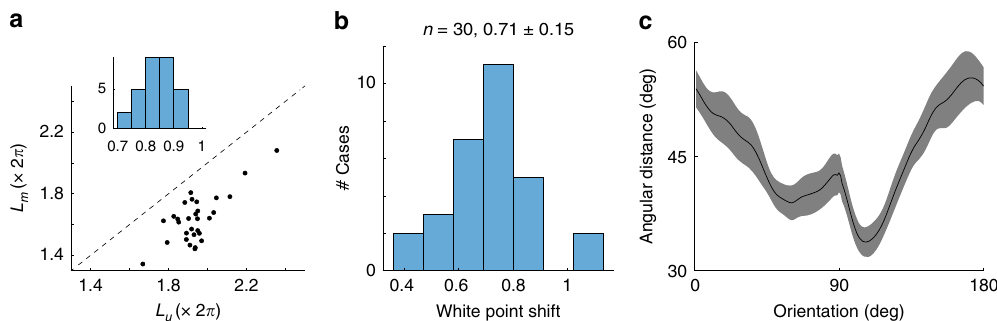
Fig. 5 Basic geometric properties of population representations in unmasked and masked conditions. a Shrinkage of the length of the curves by the introduction of the mask. Scatterplot shows the lengths of the curves in unmasked ( L u ) and masked ( L m ) conditions. Dashed line represents the unity line. Inset shows the distribution of L m / L u across all experiments. b Distribution of white-point shift ( Δ ) across all experiments. c Measurements of the angle between r m θ ð Þ and the plane span r u θ ð Þ ; r u π = 2 ð Þf g across all experiments. Solid line represents the mean, while the shaded area represents ±